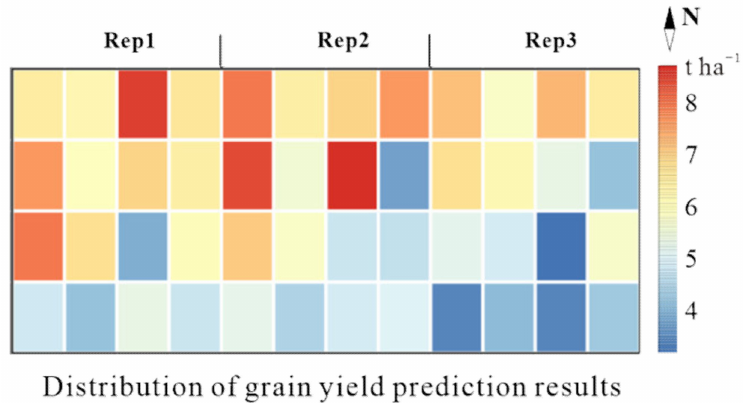
Figure A4. Spatial distribution of grain yield (t ha − 1 ) at the plot scale using an ensemble learning